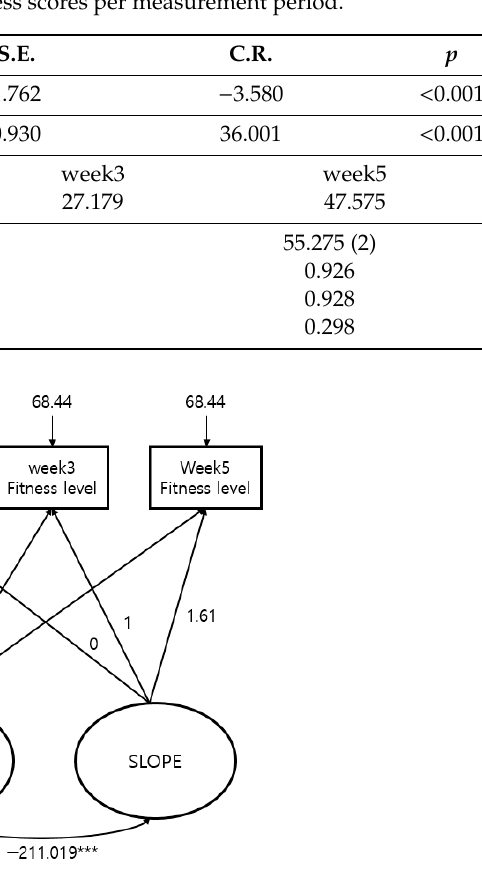
Figure 1. Fitness score model goodness of fit test results. *** p < 0.001.